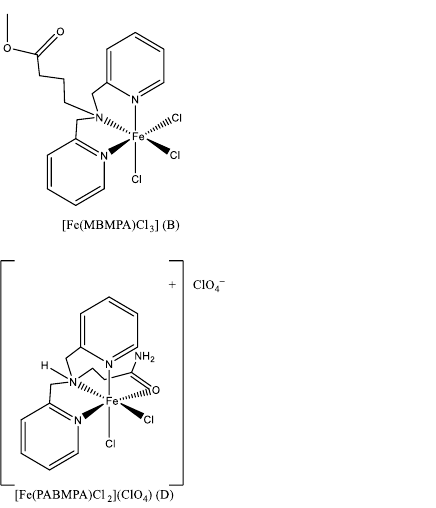
Figure 4. Structures of iron(III) containing bis-(2-pyridymethyl)amine) (BMPA) and derivatives. Adapted from [24].